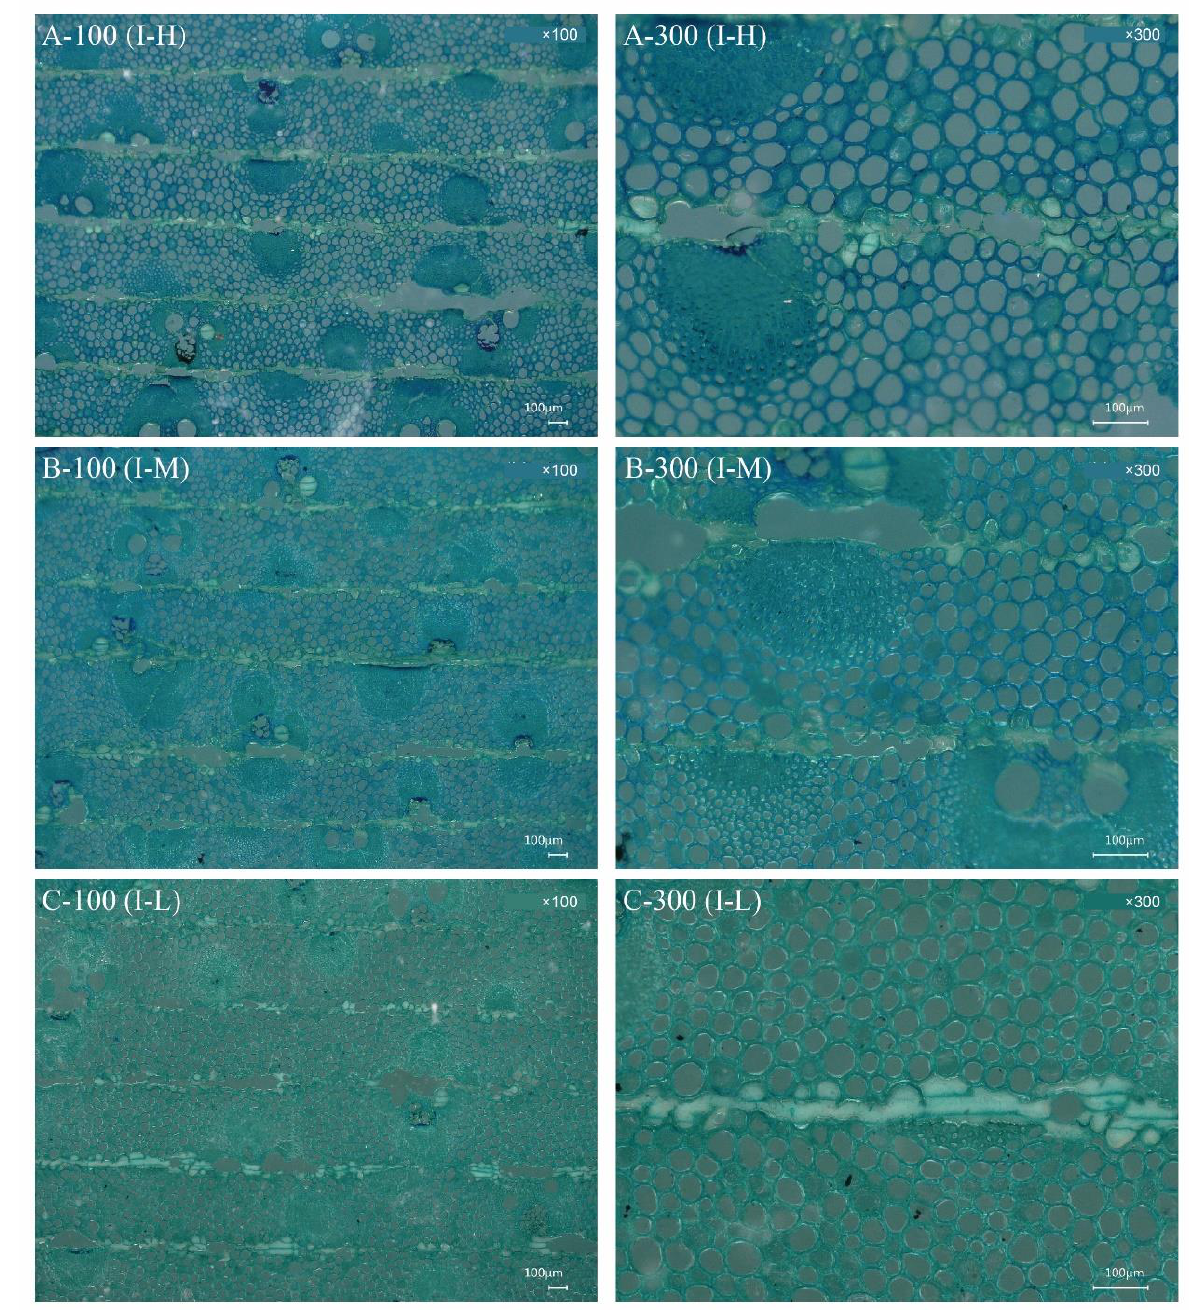
Figure 2. Photomicrographs of transverse sections of bamboo laminated composites of parallel lami- nation (type I). Resin penetration status of composites with varying fiber volumes. ( A – C ) denote types with high (I-H), medium (I-M), and low (I-L) fiber volumes, respectively; × 100 and × 300 represent magnifications; scale bar = 100 µ m. A-100, parallel lamination with high fiber volume content composites at × 100 represent magnifications; A-300, parallel lamination with high fiber volume content composites at × 300 represent magnifications; B-100, parallel lamination with middle fiber volume content composites at × 100 represent magnifications; B-300, parallel lamination with high fiber volume content composites at × 300 represent magnifications; C-100, parallel lamination with low fiber volume content composites at × 100 represent magnifications; C-300, parallel lamination with low fiber volume content composites at × 300 represent